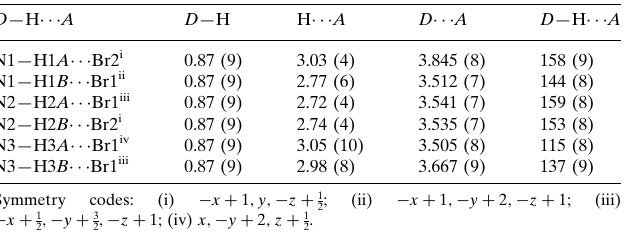
Hydrogen-bond geometry (A˚ , (cid:3)